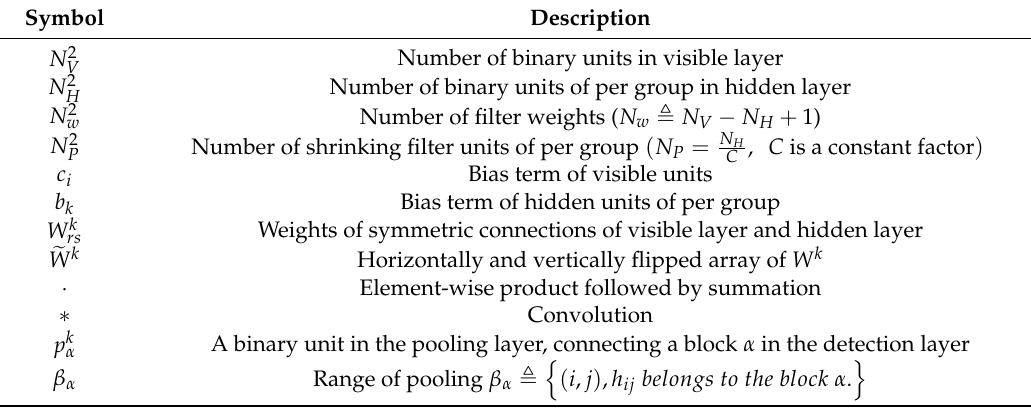
Table 4. Description of the above-mentioned variables and